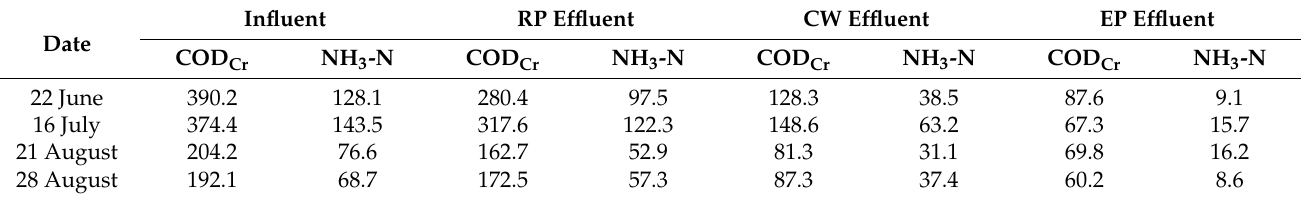
Table 1. Water quality monitoring results during the commissioning stage of the sewage treatment project